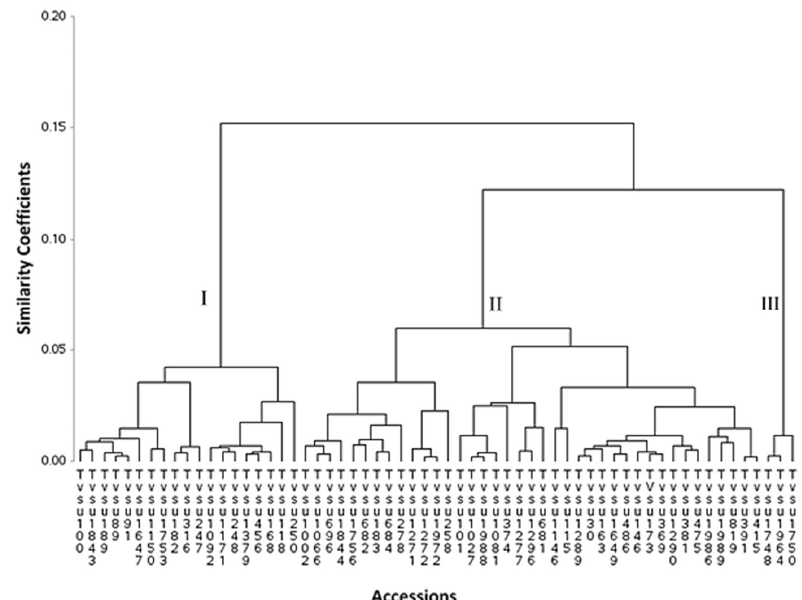
Figure 2. Dendrogram showing distinctive groupings of the 61 Bambara groundnut accession into